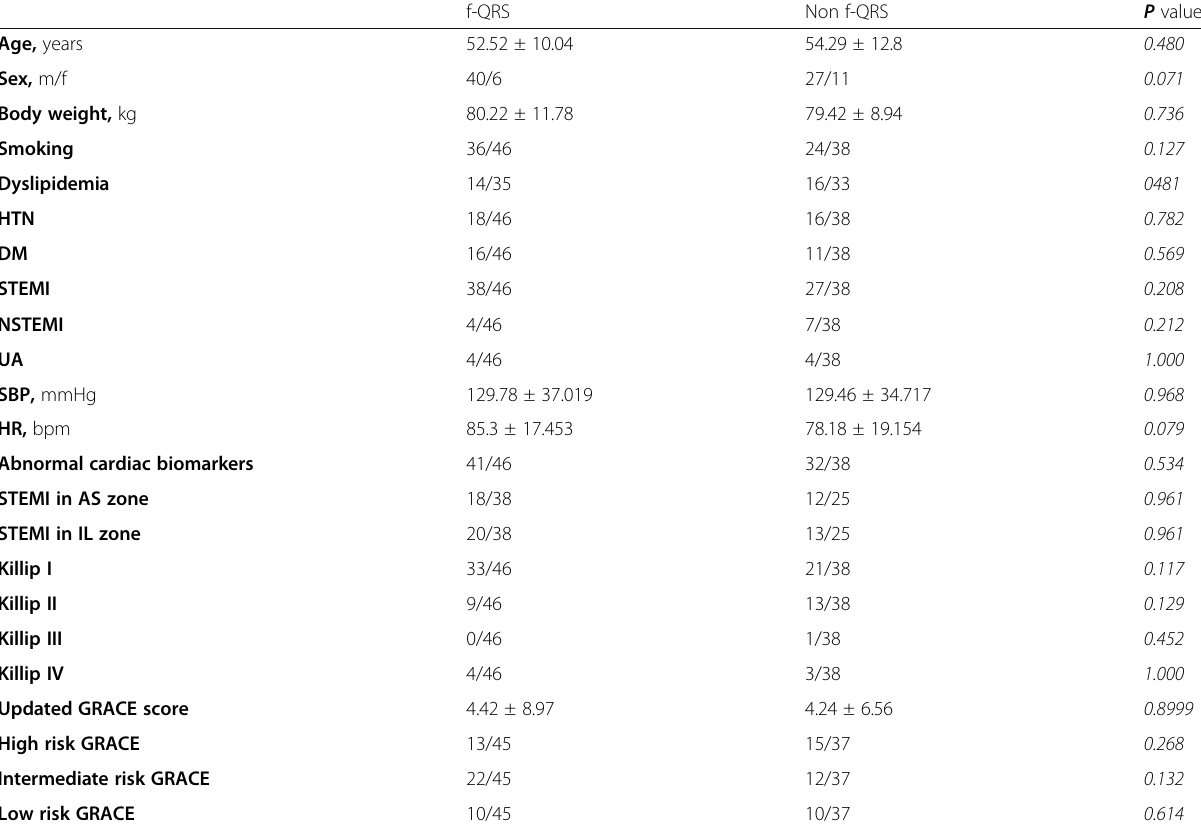
Table 1 General demographic characteristic, major risk factors, forms of ACS, (SBP and HR) on admission, positive cardiac biomarkers, location of STEMI, Killip class, risk